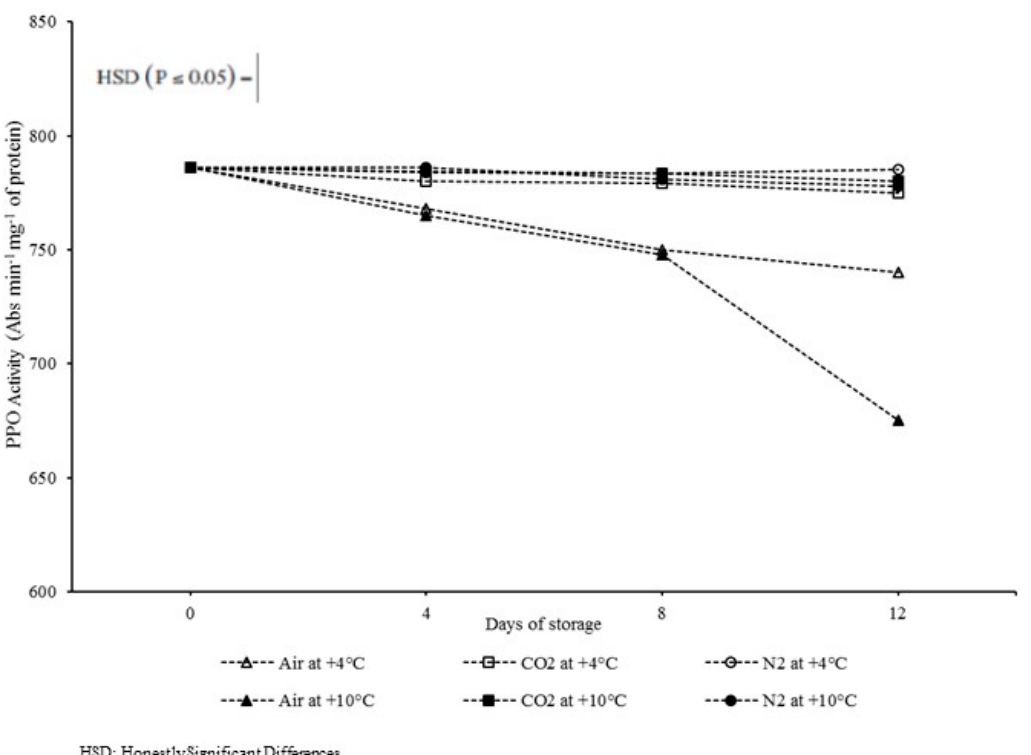
Figure 7. Polyphenoloxidase activity (PPO) 12 days of storage at +4 °C and +10 °C in air, 100 ± 1 kPa of CO 2 , and 100 ± 1 kPa of N 2 , respectively.